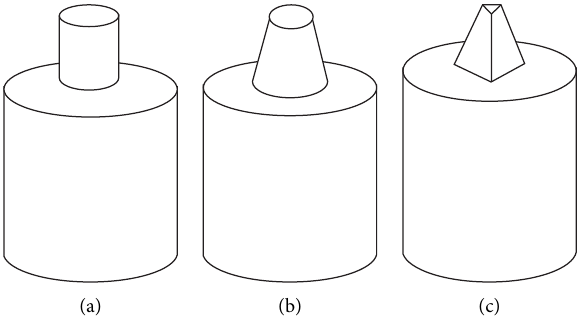
Figure 1: FSW tool. (a) Cylindrical tool, (b) Taper tool, and (c) Triangular tool. Table 3: FSW factors’ contribution and the output of tensile strength.